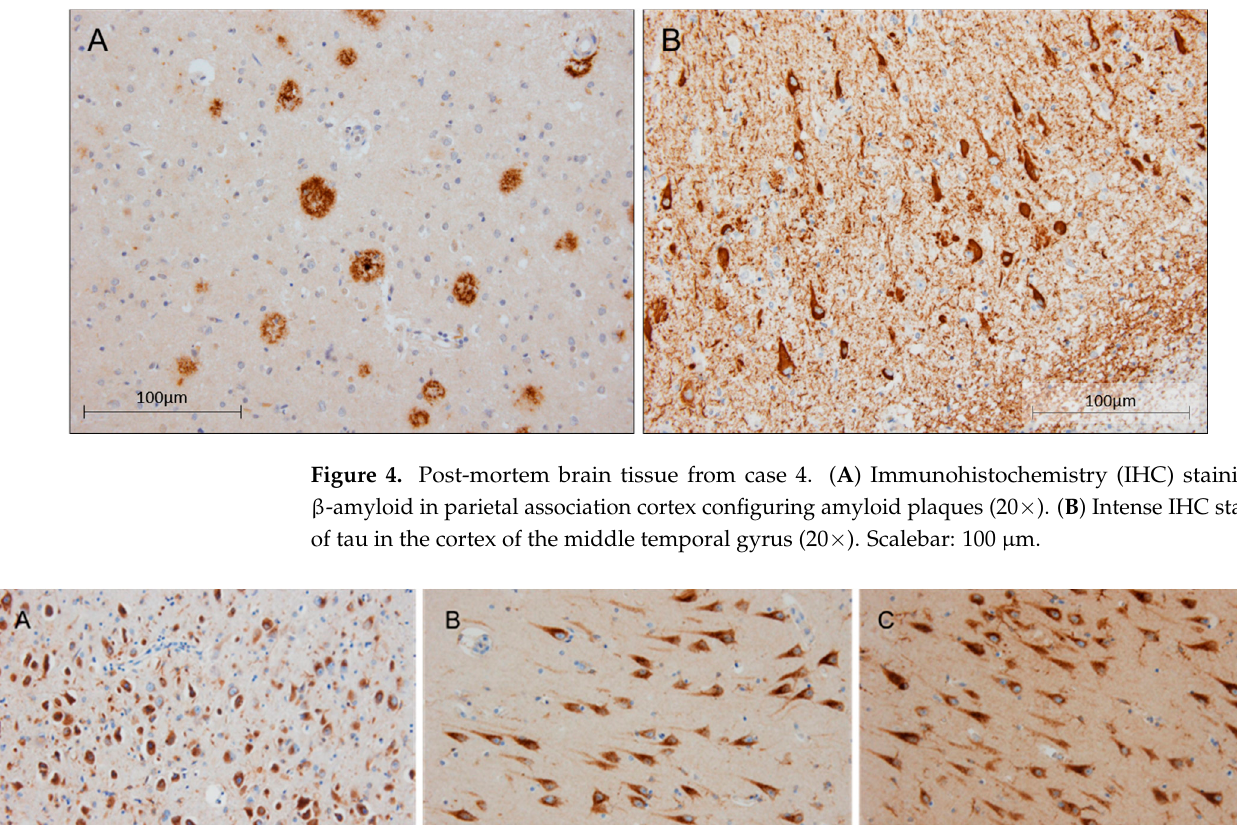
Figure 5. Immunohistochemical localization of SorLA in post-mortem brain tissue (20×). Repre- sentative pictures from ( A ) case 4, ( B ) sporadic AD, and ( C ) control in the CA1 hippocampal region using ab190684 SORL1 antibody. Scalebar: 50 μ m.